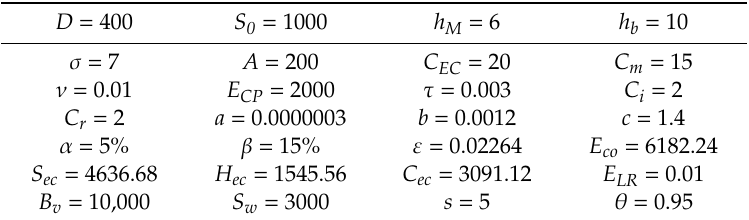
Table 2. Input parameters for Example 1.